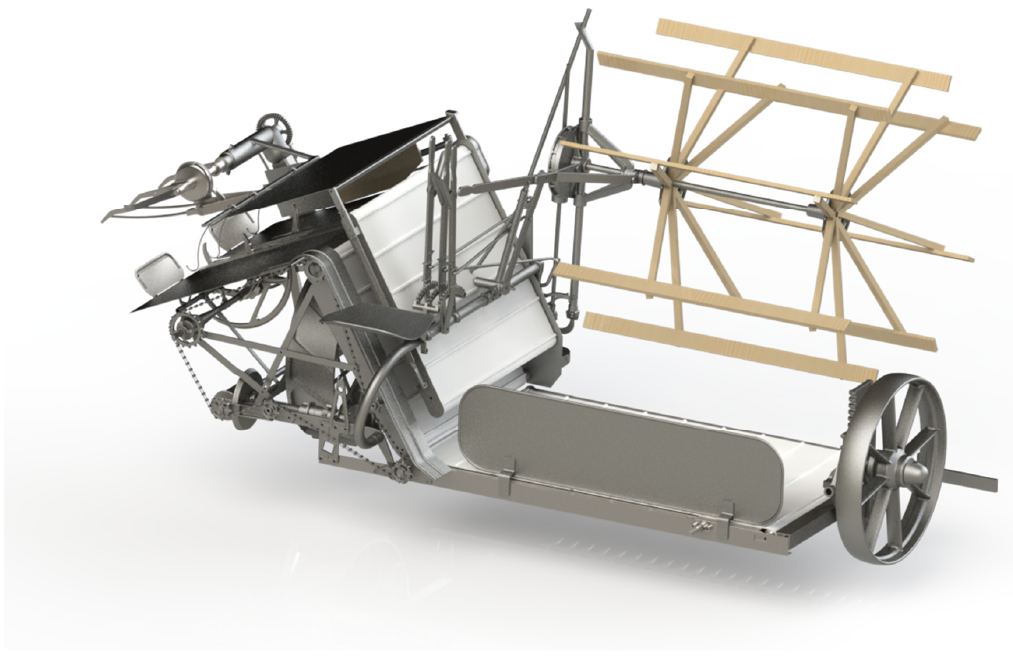
Figure 34. Back view of the final assembly.